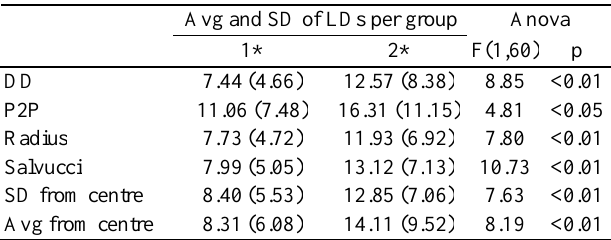
Table 4. Average Levenshtein distances (sd in brackets) between the benchmark scan path and the scan paths as returned by the various metrics and threshold settings Avg and SD of LDs per group